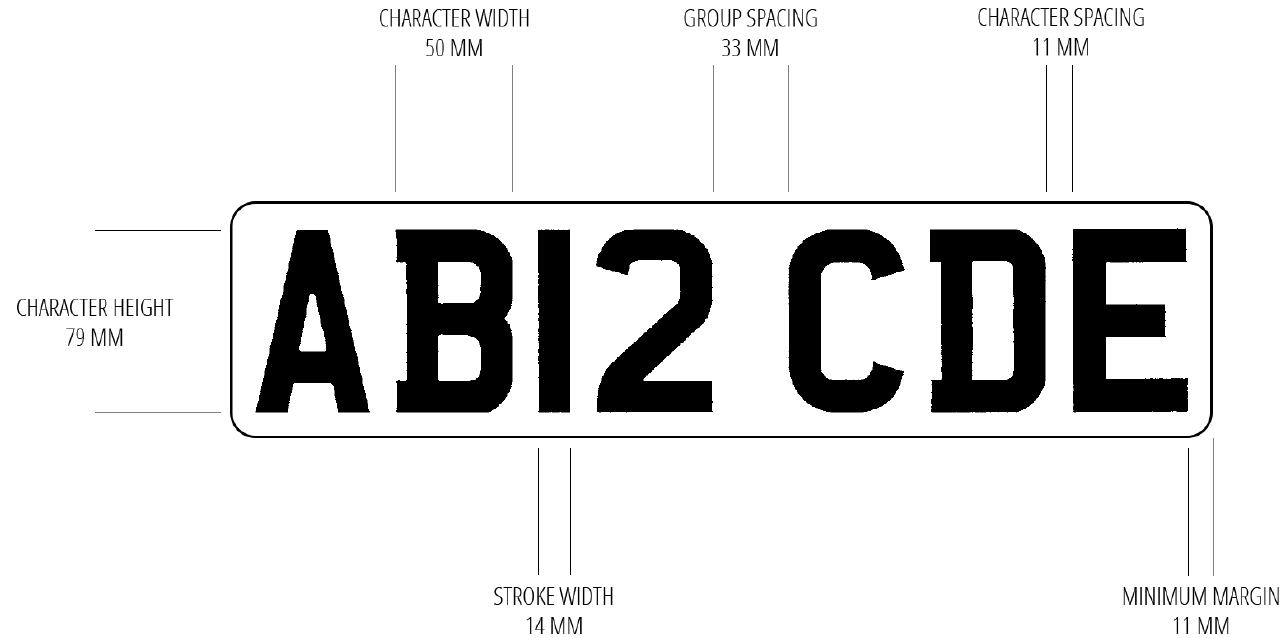
Figure 2. Diagram of Registration Plate Visual Design Requirements, following the 2001 Regulations The intricacy of these regulations indicates a regulatory desire for these figures to have a particular appearance. Meanwhile, the error bounds in s 12(2) indicate a degree of practical concession, accepting that the imagined form remains contingent upon a material—and thus imperfect—expression of the legally described ideal. Indeed, it is arguably impossible to encounter registration marks as purely intellectual or idealised legal objects, since they are invariably contingent upon some form of material expression—be it via indicative description in the 1994 Act, the graphic expression mandated by the 2001 Regulations or a sensory encounter with affixed marks themselves. The recognition of this contingency is in a sense ab initio : in typographic parlance, the typeface is the ‘design of the letterforms’, the ‘punches from which molds are made’, the ‘visual design’ in a digital system, while the font is the ‘delivery mechanism’, the ‘cast metal’, the ‘software that allows you to install, access, and output’ the text. 29 By denoting the prescribed letterforms as a ‘font’ rather than a typeface, the 2001 Regulations acknowledge their material contingency from the moment of their initial